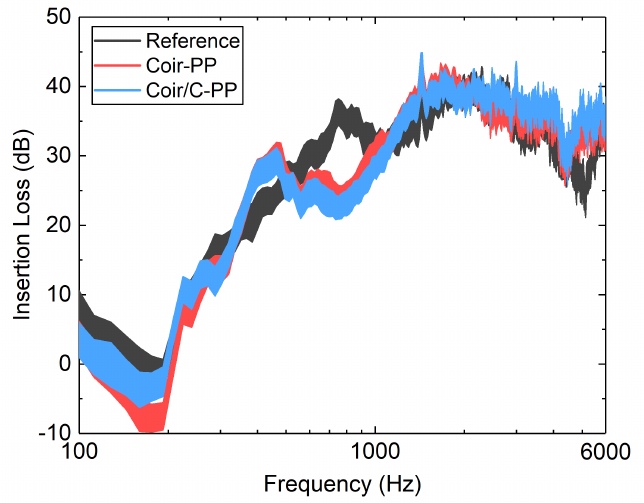
Figure 4. Insertion loss curves of the reference earmuff (dark grey), the Coir-PP earmuff (red), and the Coir/C-PP earmuff (blue) in pink noise. Shaded area is bounded by the upper and the lower limits of the expanded uncertainty at a confidence level of 95%. Note that the frequency interval is 16